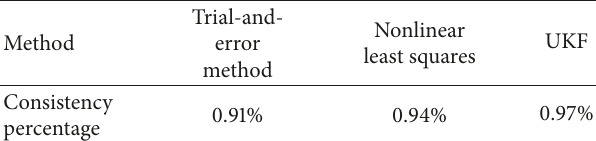
Table 7: Consistency percentage of results based on simulated values of different